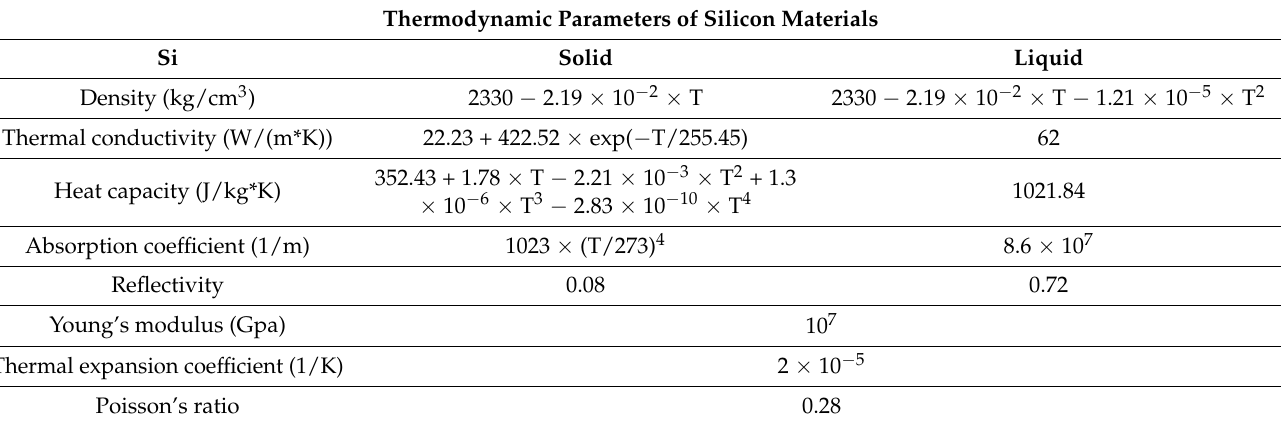
Figure 1. Schematic diagram of simulation model. The symbol “D” denotes the heat source volume, and the symbol “E” indicates the symmetric boundary. Table 1. Thermodynamic parameters of silicon at the wavelength of 3.8 µ